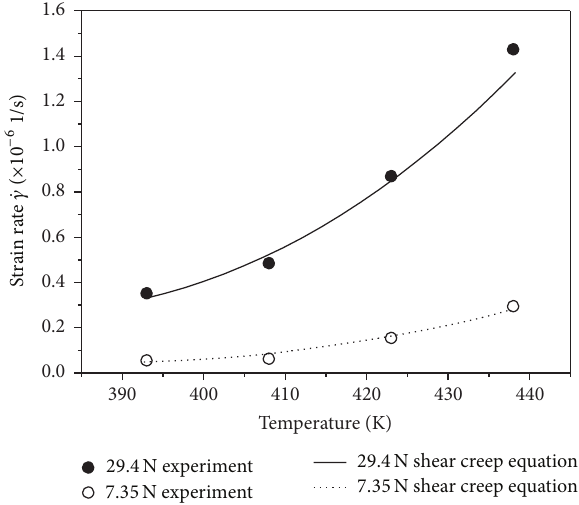
Figure15:Correlationbetweenshearcreepequationsstrainrateand